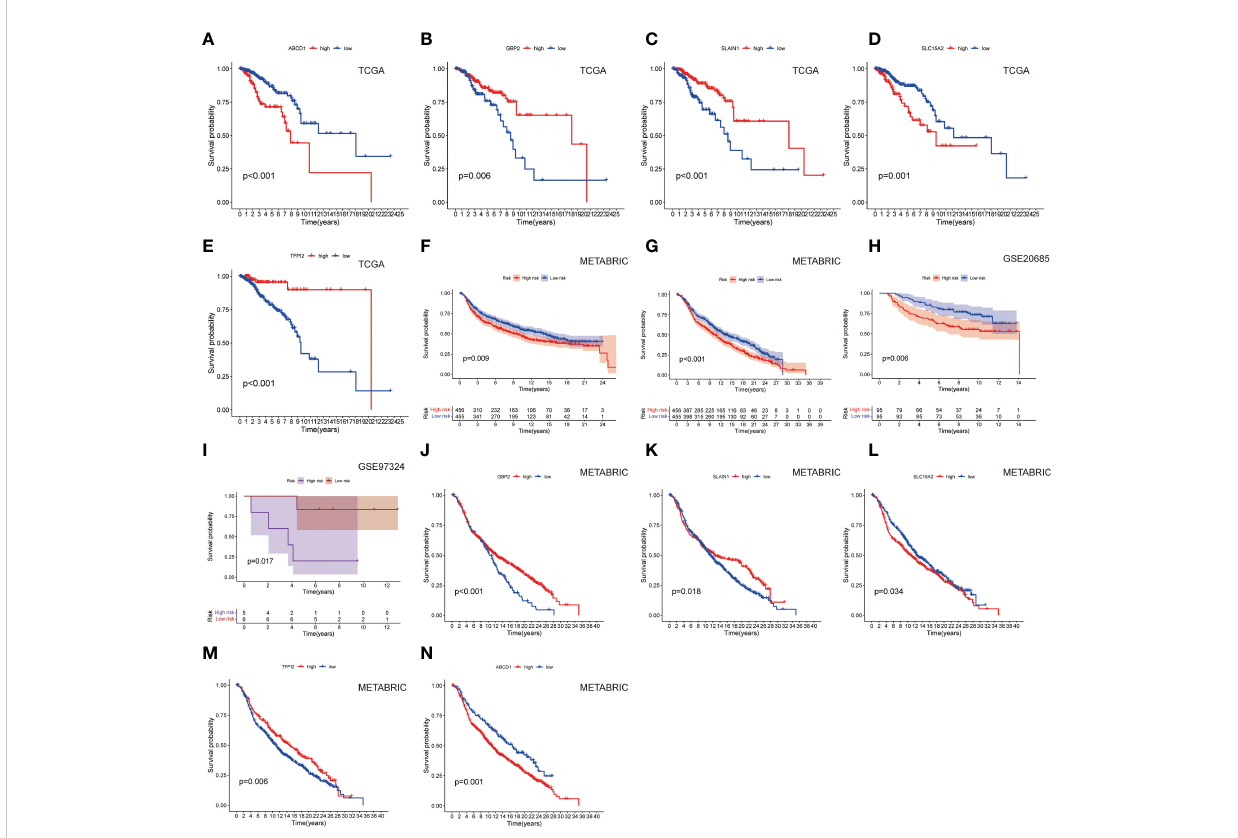
FIGURE 4 The survival curves of (A) ABCD1, (B) GBP2, (C) SLAIN1, (D) SLC15A2, and (E) TFPI2 based on LNPRS in the training cohort. The survival curves of the (F) METABRIC cohort (overall survival), (G) METABRIC cohort (relapse-free survival), (H) GSE20685 cohort, and (I) GSE97324 cohort. The survival curves of (J) GBP2, (K) SLAIN1, (L) SLC15A2, (M) TFPI2, and (N) ABCD1 in the METABRIC